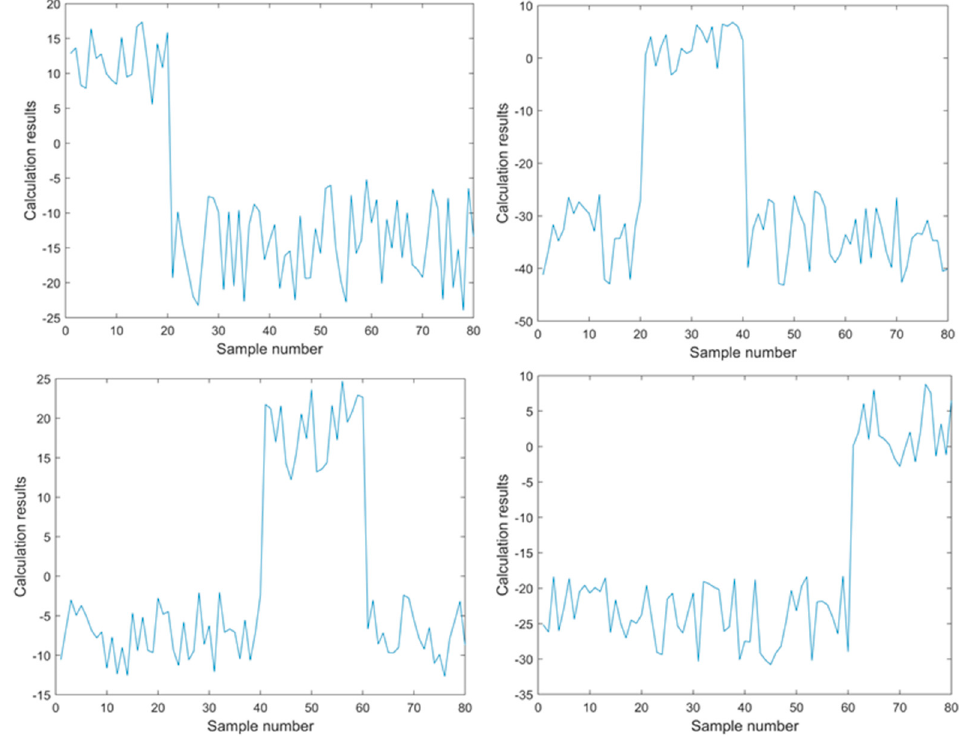
Figure 10. Calculated results of four types of samples under the original hyperplane. Using the CSH-SVM improvement algorithm, the resulting values obtained for